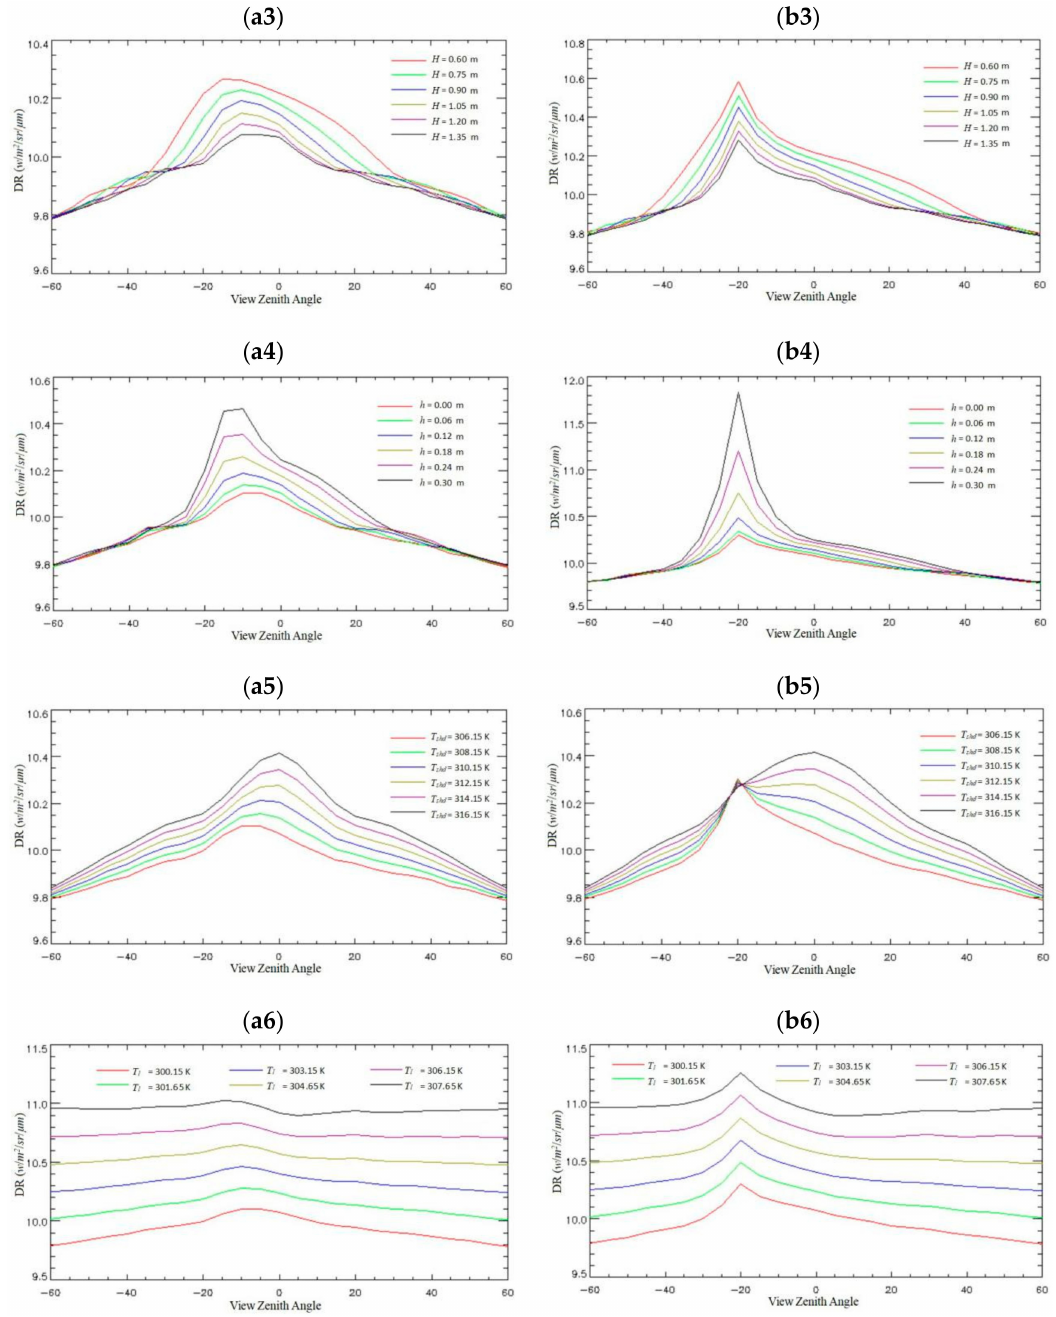
Figure 10. Sensitivity analysis of input parameters. ( a1 ) and ( b1 ) Sensitivity analysis of LAI in crossing row plane (CRP) and solar principle plane (SPP), respectively. ( a2 ) and ( b2 ) Sensitivity analysis of row width in CRP and SPP, respectively. ( a3 ) and ( b3 ) Sensitivity analysis of height of upper edge of row in CRP and SPP, respectively. ( a4 ) and ( b4 ) Sensitivity analysis of height of bottom edge of row in CRP and SPP, respectively. ( a5 ) and ( b5 ) Sensitivity analysis of CT of shaded soil in CRP and SPP, respectively. ( a6 ) and ( b6 ) Sensitivity analysis of CT of leaf in CRP and SPP,